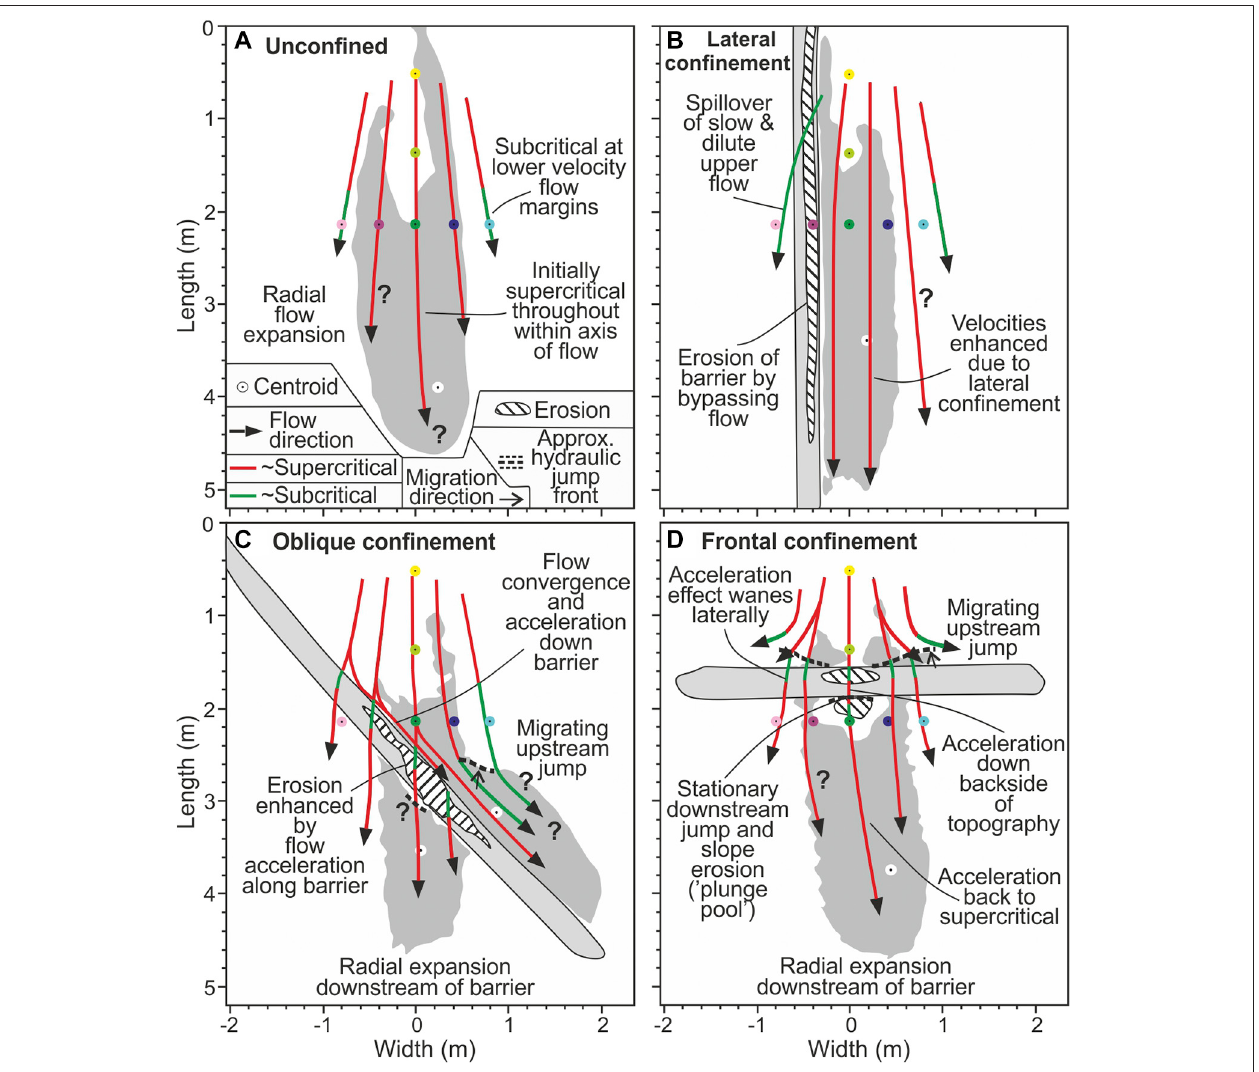
FIGURE 10 | Flow pathways and criticality for each of the runs. Criticality is based on UVP measurements. Criticality down-dip of UVPs is inferred based on sedimentary architecture.